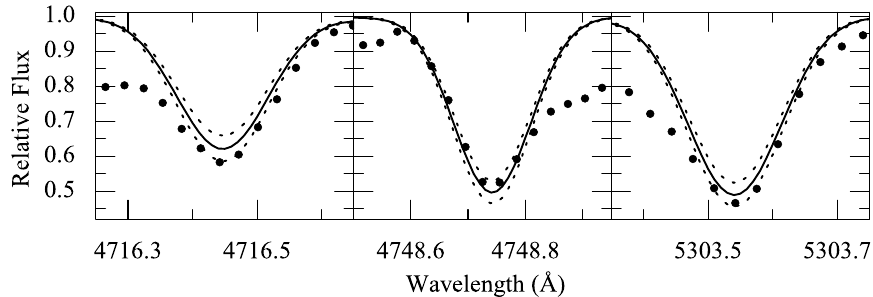
Fig. 17. La II lines in the spectrum of HD 209621. The three synthetic profiles are given for the lanthanum abundance log ϵ (La) = 1 . 10 ± 0 .